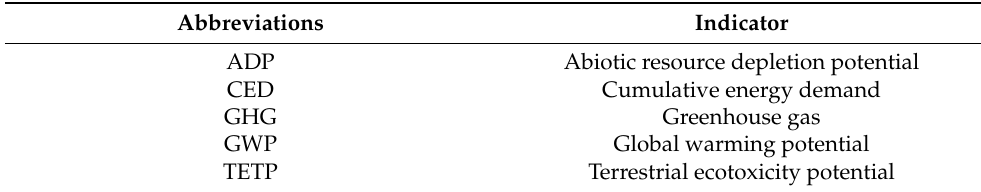
Table 2. Overview of the main indicators for monitoring the environmental impact.